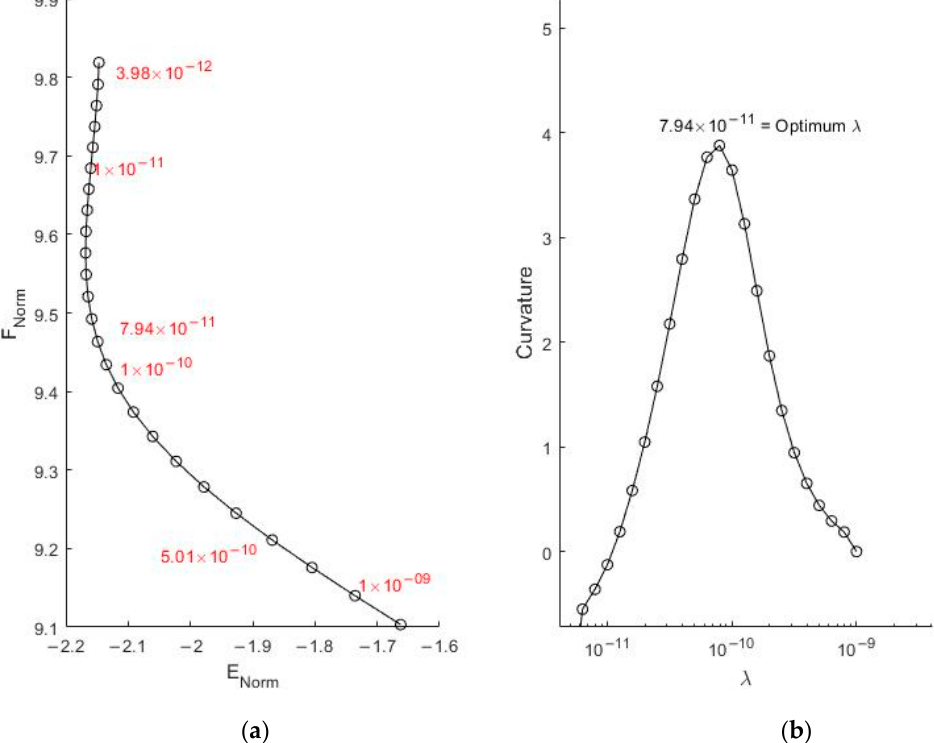
Figure 2. ( a ) L curve for 18 t vehicle passing at 25 m/s and ( b ) curvature of L curve vs. λ .